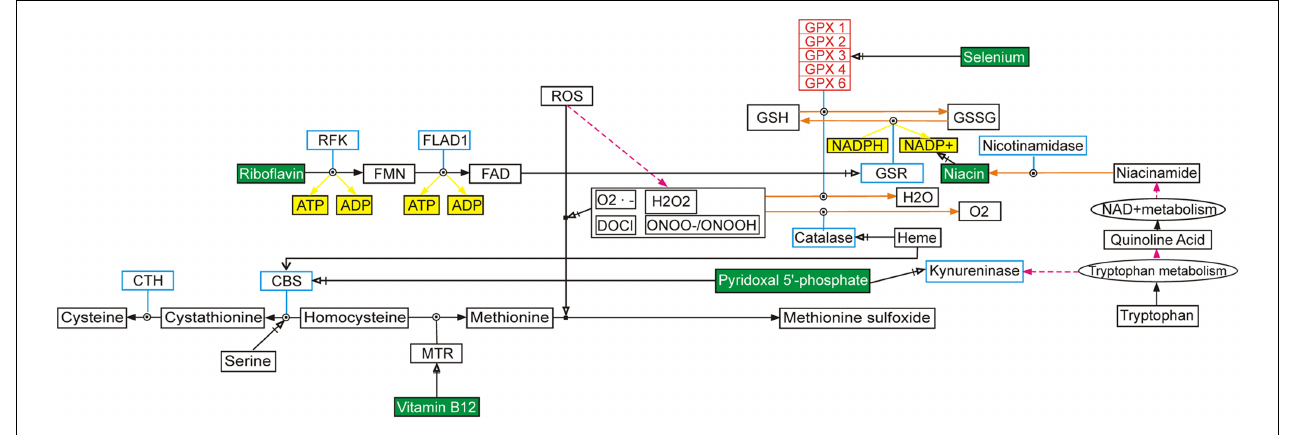
FIGURE 1 | Illustration of the complexity of gene-gene interactions, using selenium and selenoproteins as an example. This selenium pathway